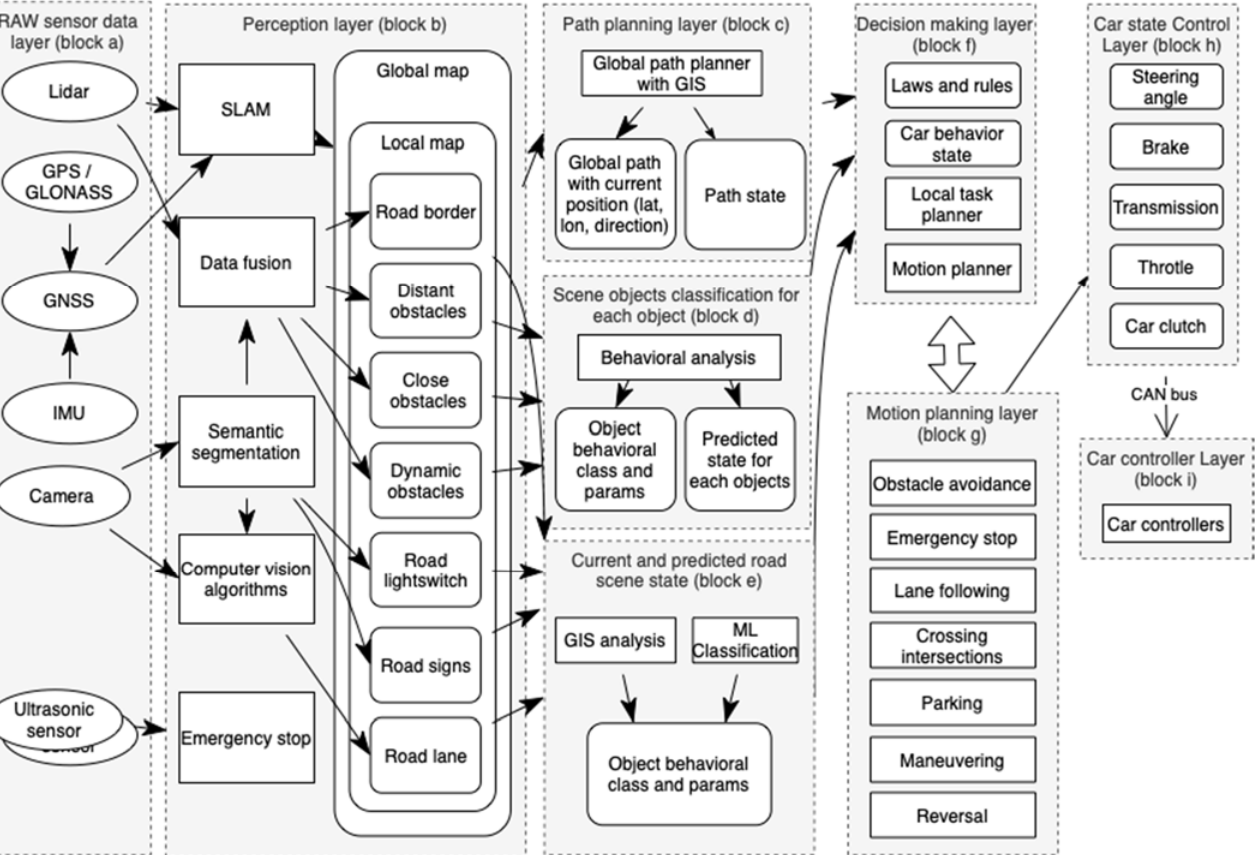
Figure 1. Structural and functional model of the control system of a self-driving car.